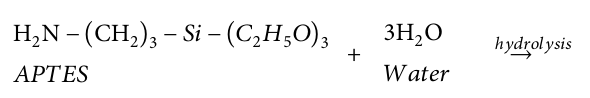
Figure 2: Representative FT-IR spectra of the (a) untreated AC, (b) SH 400–4000cm − 1 with 8 cm − 1